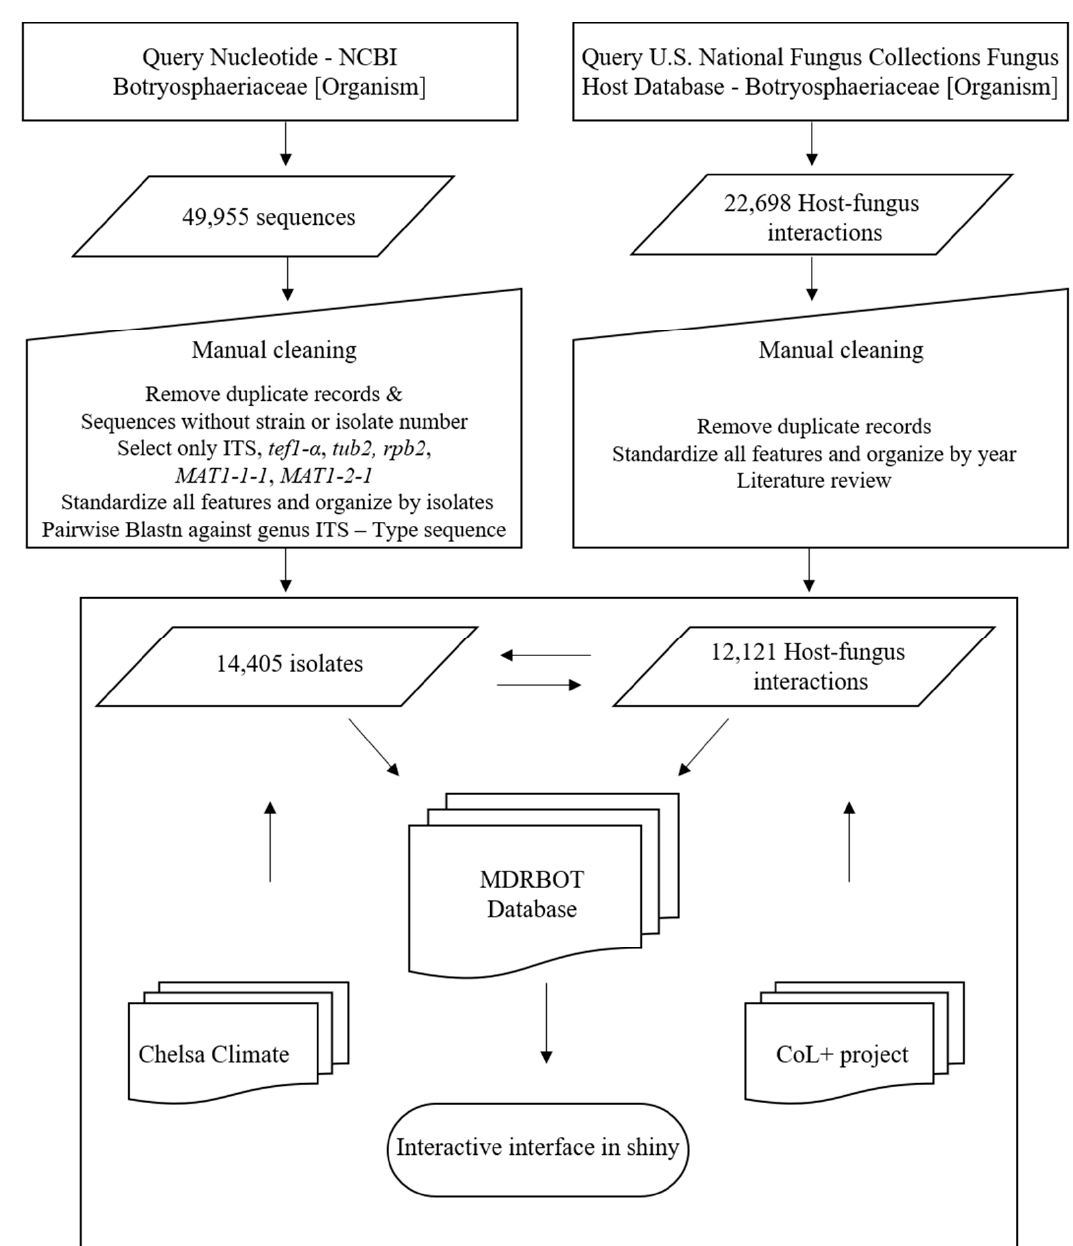
Figure 1. Workflow overview to cure and organize data extracted from the Nucleotide—NCBI database and the U.S. National Fungus Collections. Final output originated the Map Detect and Research BOTryosphaeriaceae database, which can be accessed through an interactive shiny interface.